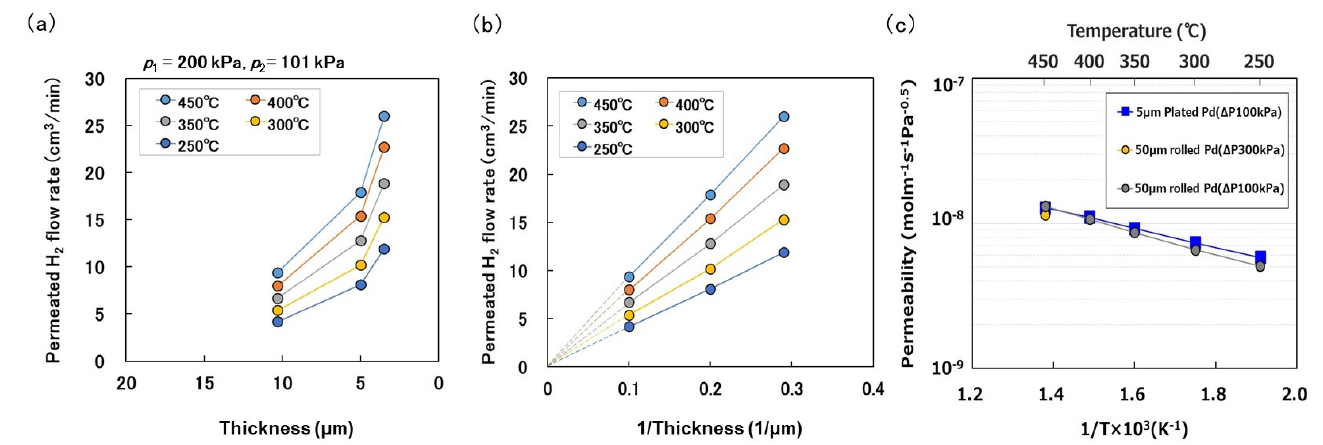
Figure 4. ( a ) Dependence of the permeated hydrogen flow rate on film thickness at various tempera- tures. ( b ) Dependence on the thickness (1/thickness) of permeated hydrogen flow rate at each film thickness. ( c ) Temperature dependence of the hydrogen permeabilities of plated Pd (5 μ m thickness) and rolled Pd (50 μ m thickness) at 250–450 °C. The experimental conditions are indicated in the figure.